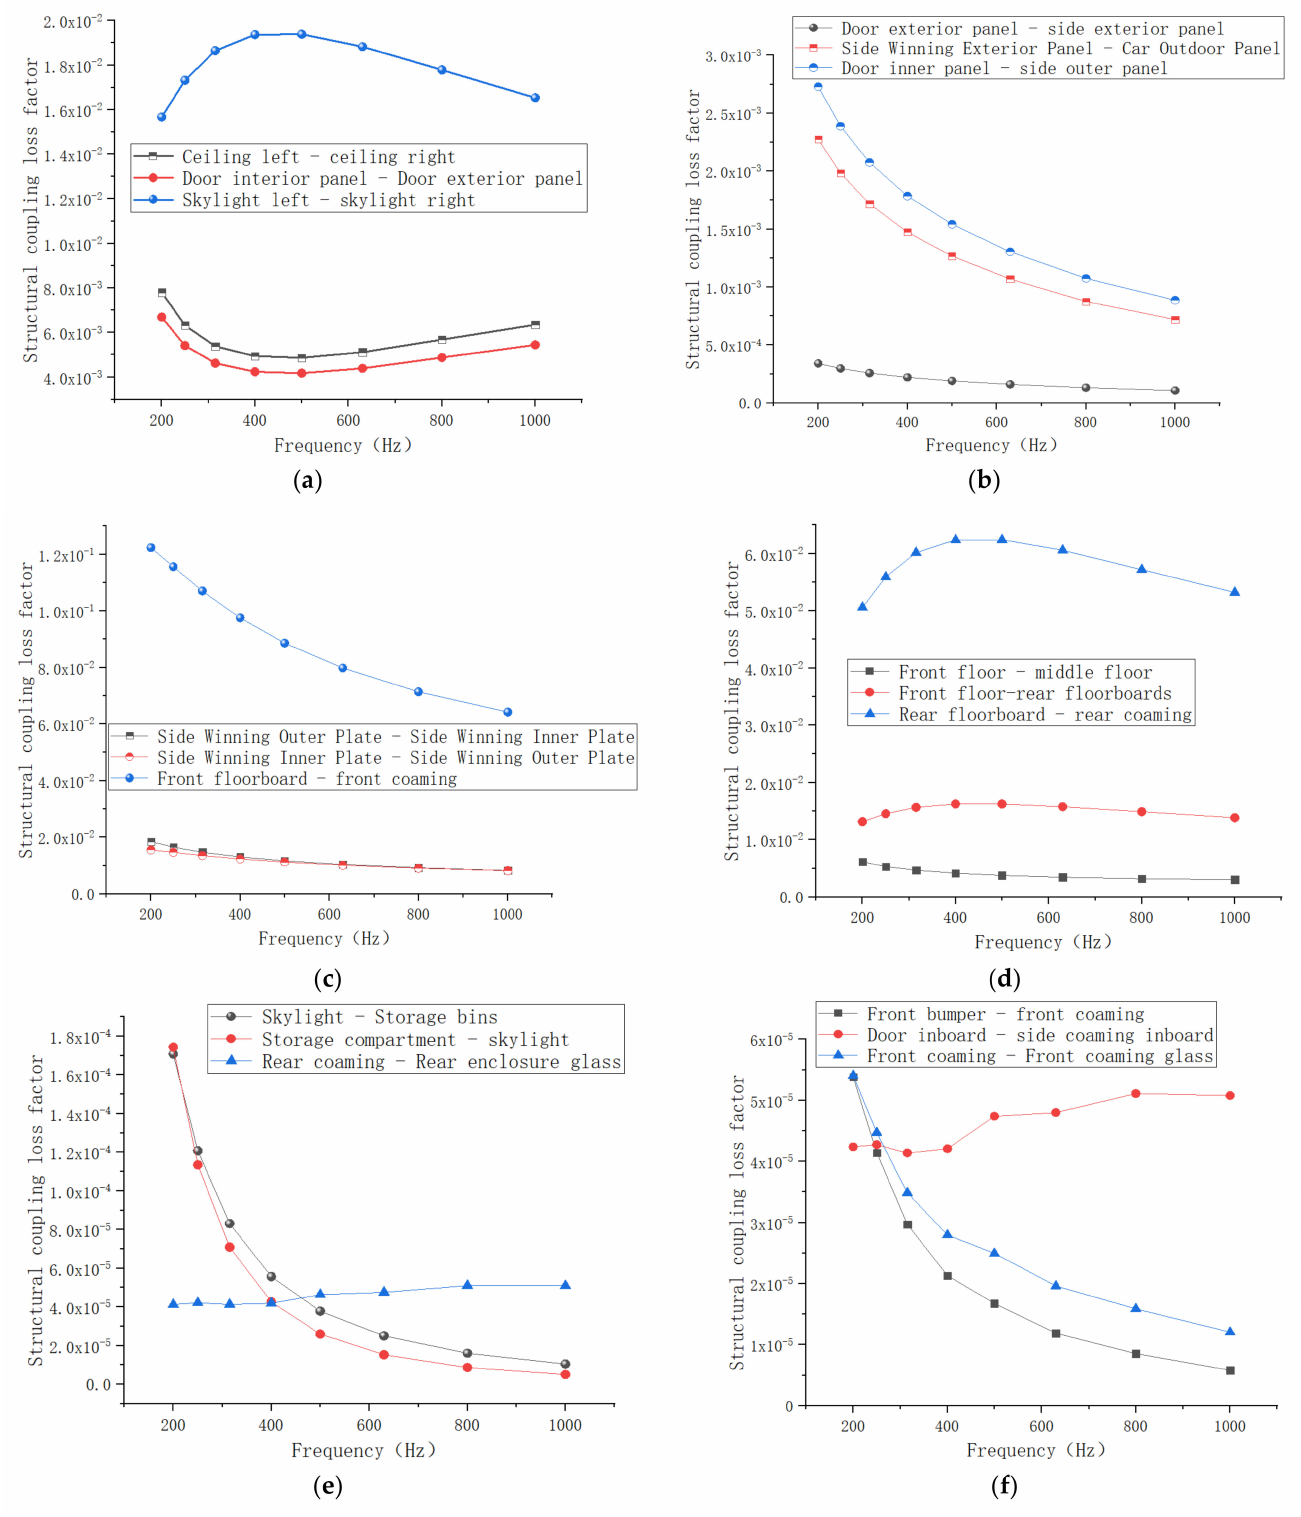
Figure 10. The coupling loss factor of different structures. ( a ) Coupling loss factor of roof and other structures; ( b ) Coupling loss factors of door panels and other structures; ( c ) Coupling loss factor for front floor and other structures; ( d ) Coupling loss factors for structures such as rear floors; ( e ) Coupling loss factor of rear coaming and other structures; ( f ) Coupling loss factor of front bumper and other